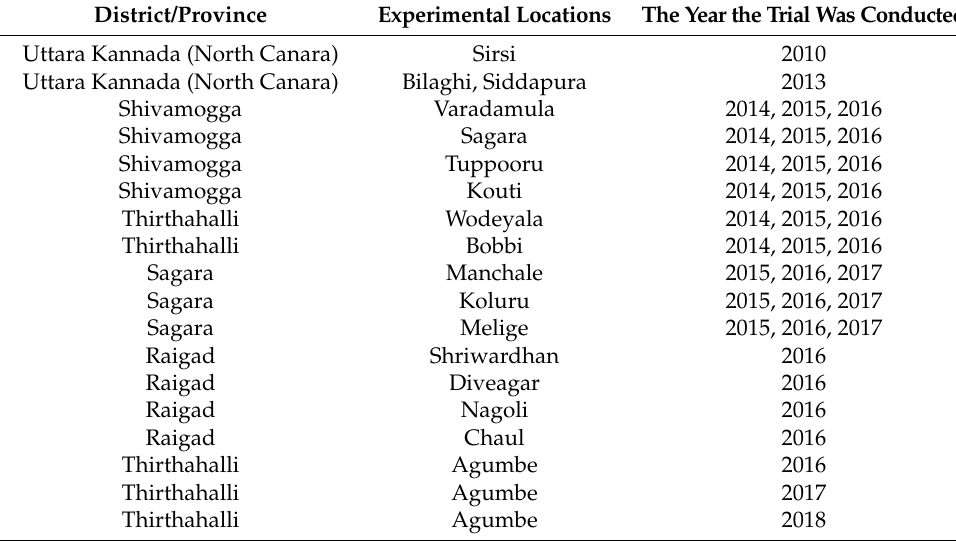
Table 2. Descriptions of the locations of the experimental trials conducted in different provinces against FRD in